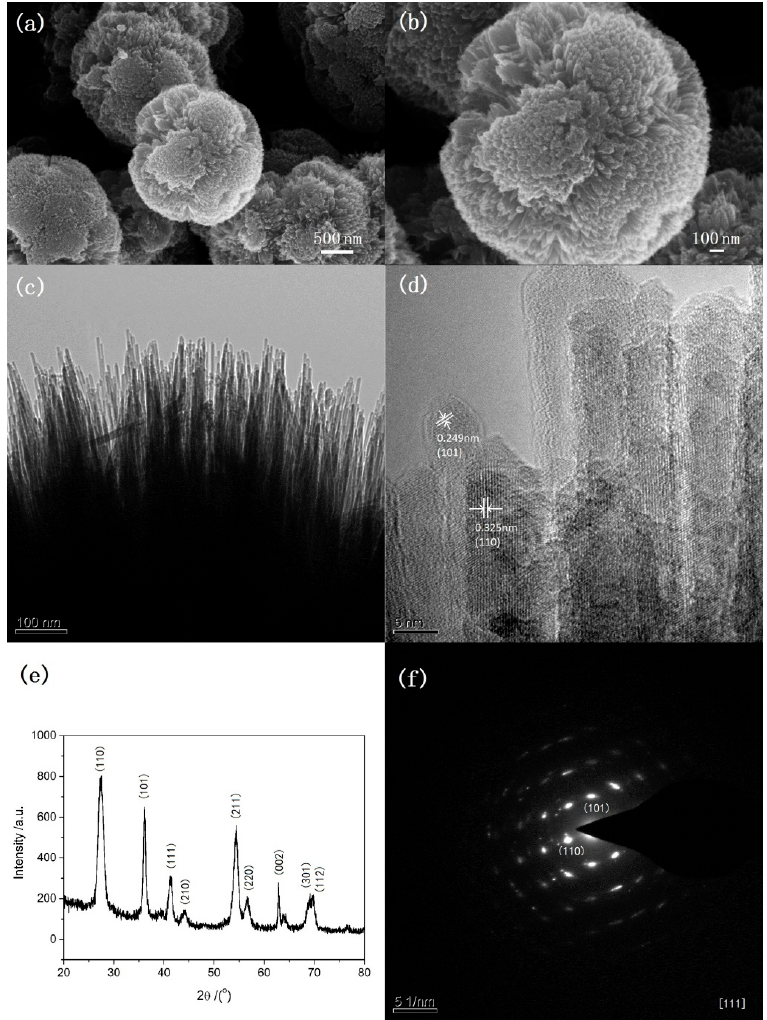
Figure 1. Scanning electron microscope (SEM) images ( a , b ), transmission electron microscope (TEM) images ( c , d ), X-ray diffraction (XRD) ( e ) and selected area electron diffraction (SAED) pattern ( f ) of the urchin-like titanium oxide (TiO 2 ) synthesized at 135 °C under microwave irradiation for 5 min.